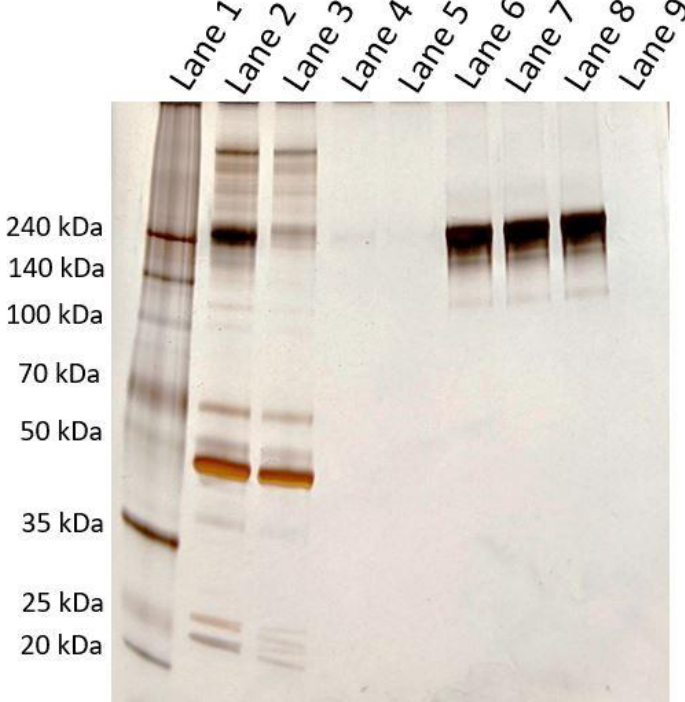
Figure 12. SDS-PAGE analysis of the IgG eluates of the protein A column in three subsequent runs (purification and two reinjections). Lane 1: Size standards, Lane 2: Raw plasma, Lane 3: Flow-through peak of raw plasma injection, Lane 4: Flow-through peak (reinjection 1), Lane 5: Flow-through peak (reinjection 2), Lane 6: IgG eluate of raw plasma injection, Lane 7: IgG eluate after first reinjection, Lane 8: IgG eluate after second reinjection. The first passage shows nearly all concomitant proteins from the human plasma in the void peak (Lane 3). Nearly all IgG was removed from the plasma (150 kDa). In the second and third passages, only low amounts of protein could be detected in the void peaks. The purity of the product peak (human IgG) seems to be very similar in all three runs (Lanes 6, 7, 8). Lane 9: Binding buffer as a blank.